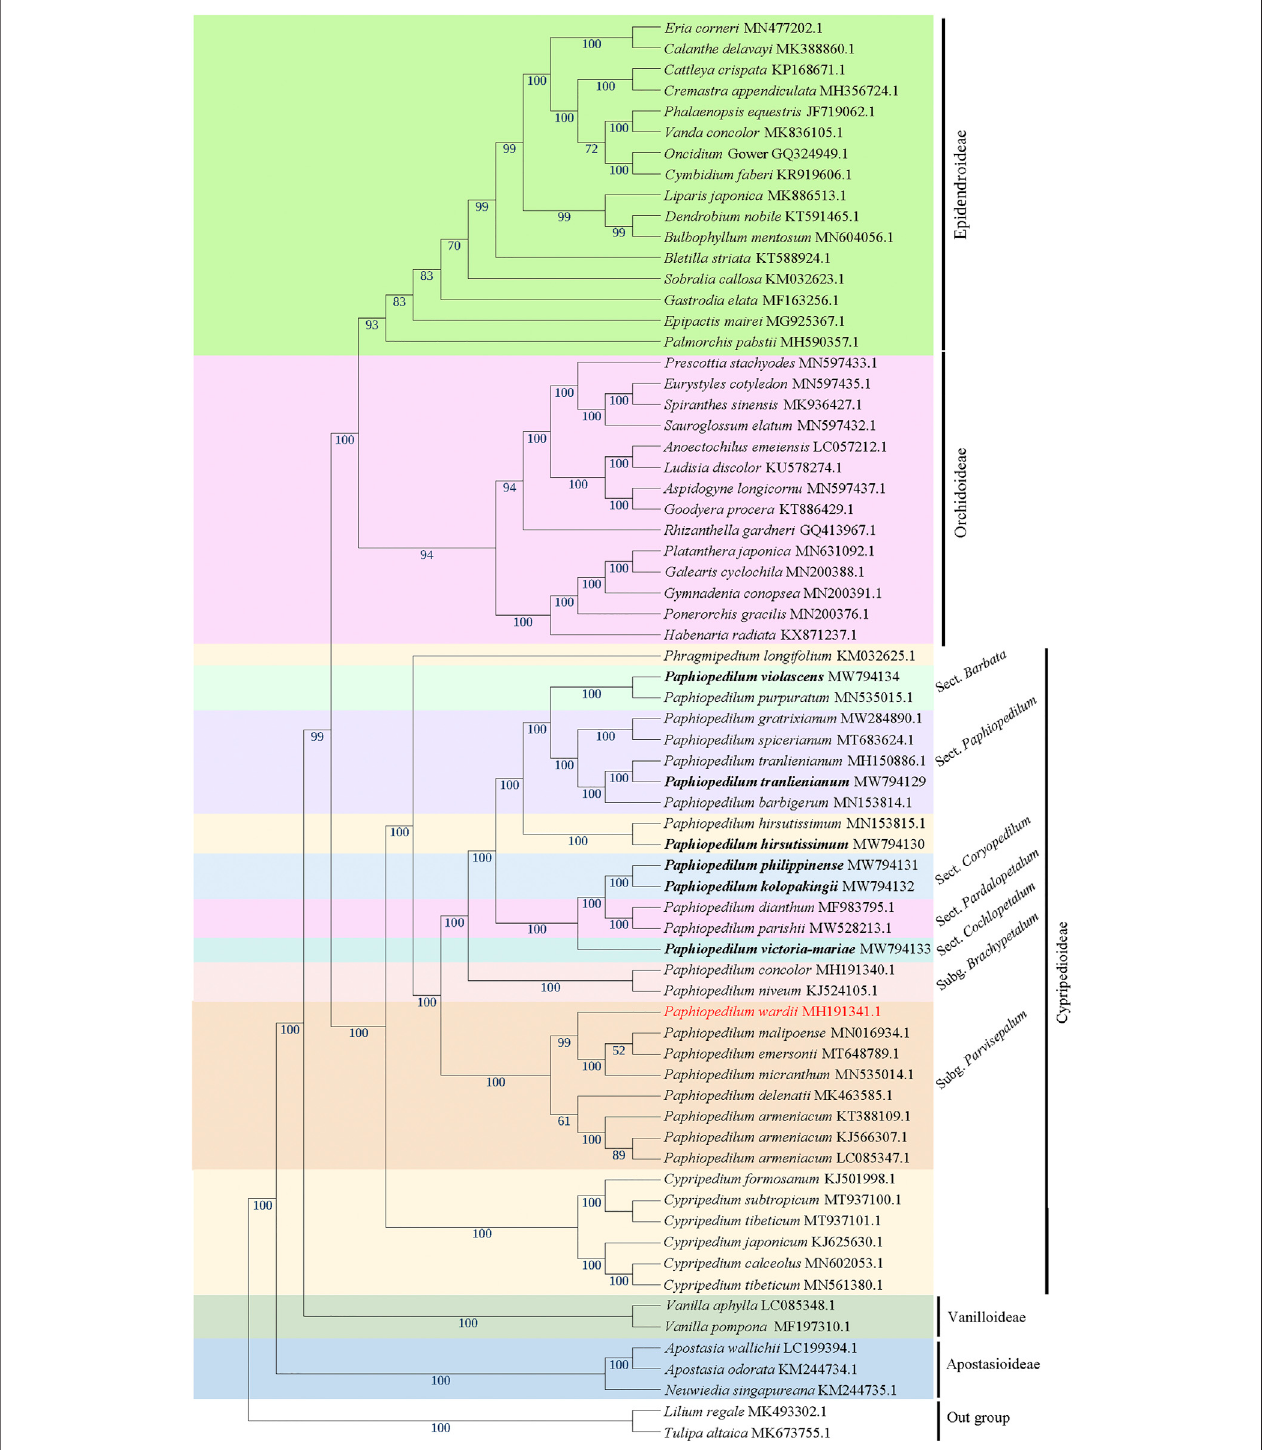
FIGURE 8 | The ML phylogenetic tree based on 66 complete chloroplast genome sequences from Orchidaceae, with Lilium regale and Tulipa altaica as outgroup. The six taxa we sampled in this study are highlighted in bold. Bootstrap values with 1,000 replicates are indicated at nodes. The GenBank accession numbers of the cp genomes are listed behind the Latin names of the species. The species that may be mistaken in name is marked in red.